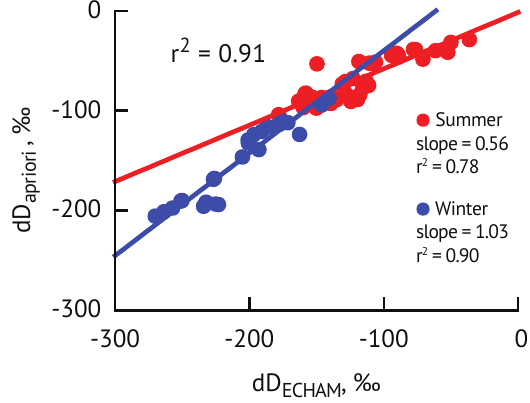
Figure 12. Winter and summer δ D calculated from retrieved H 2 O using Eq. (1) vs. ECHAM5-wiso output without FTIR retrieval of HDO.